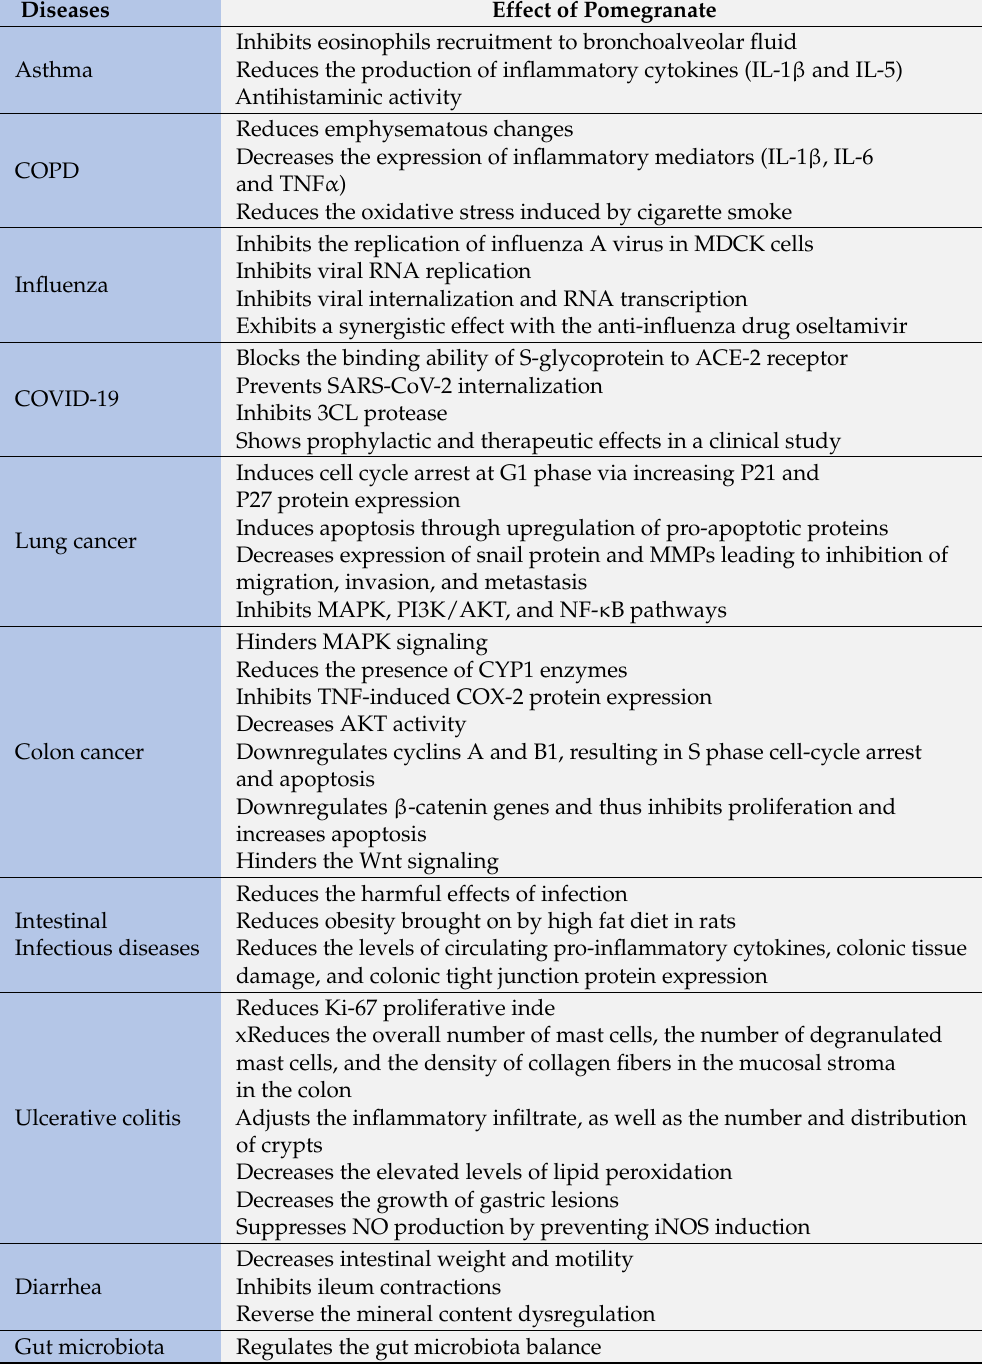
Table 1. Summary of pomegranate’s effect on respiratory and digestive